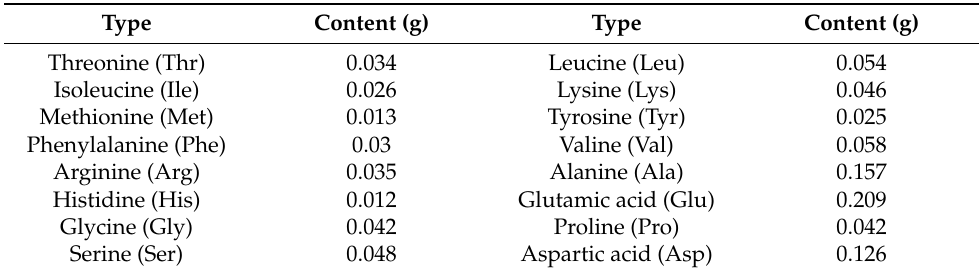
Table 2. Amino acid (aa) composition per 100 g of fresh D. longan Lour fruit pulp (acquired from the USDA National Nutrient Database (https://fdc.nal.usda.gov/fdc-app.html#/food-details/169089 /nutrients; accessed on 10 September